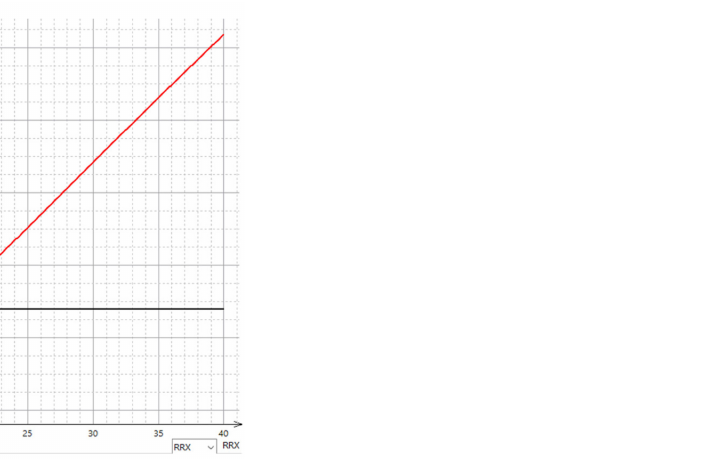
Figure 13. R RX variation simulation results of circular coil model: L 1 in the function of R RX , L 2 in the function of R RX .